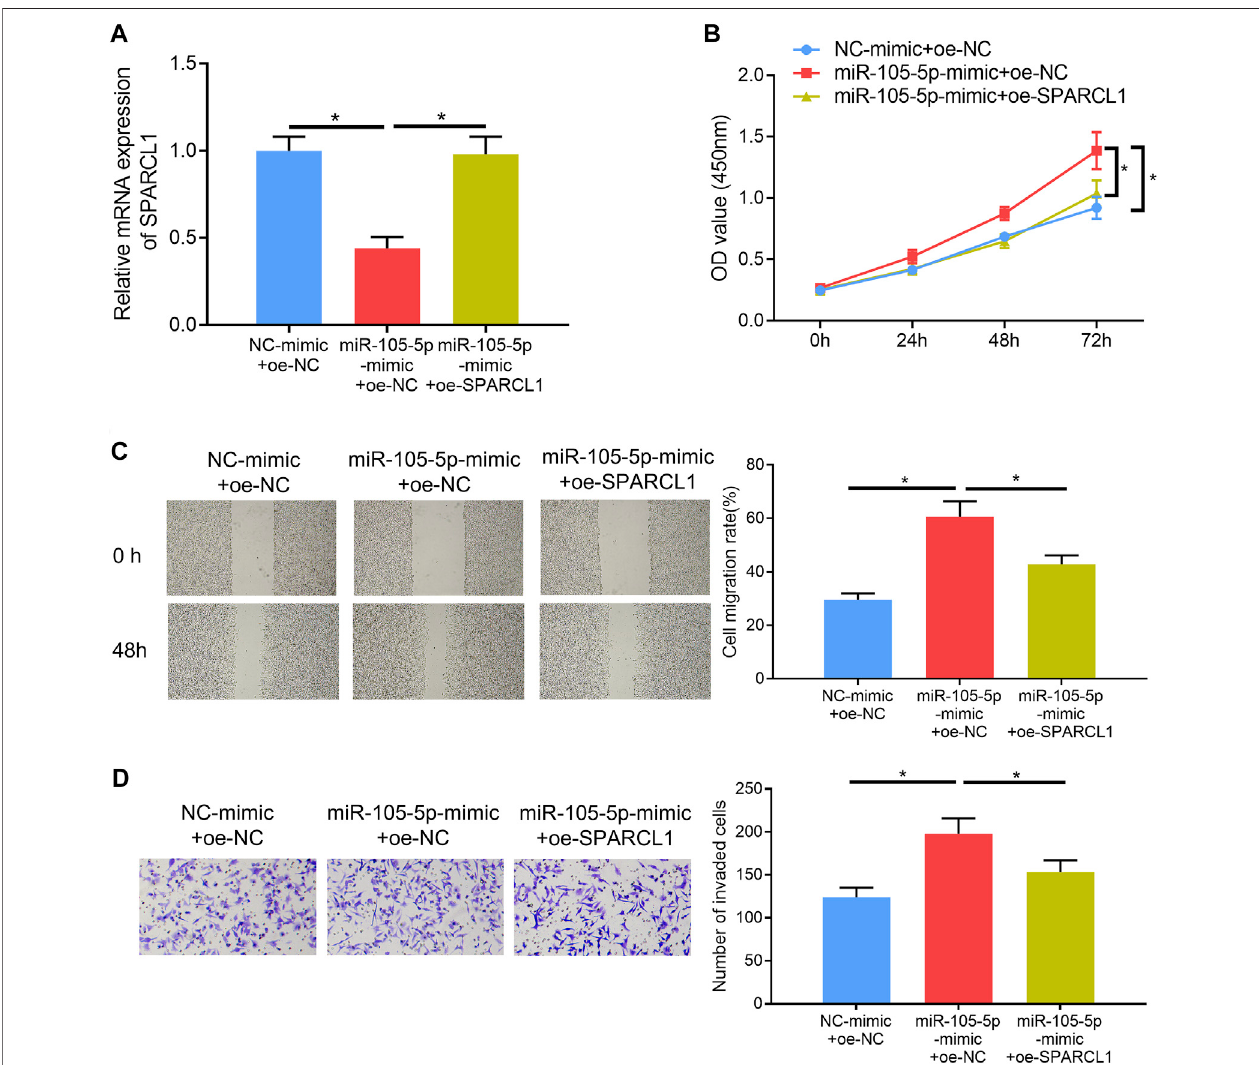
FIGURE 4 | MiRNA-105-5p regulates ESCC cell proliferation, migration, and invasion by targeting SPARCL1. (A) SPARCL1 expression in TE-1 cells transfected with NC-mimic + oe-NC, miRNA-105-5p-mimic + oe-SPARCL1, and miRNA-105-5p-mimic + oe-NC; (B – D) TE-1 cell proliferation, migration, and invasion in each group were tested via CCK-8 assay (B) , wound healing assay (×40) (C), and Transwell invasion assay (×100) (D) , respectively; * p < 0.05.